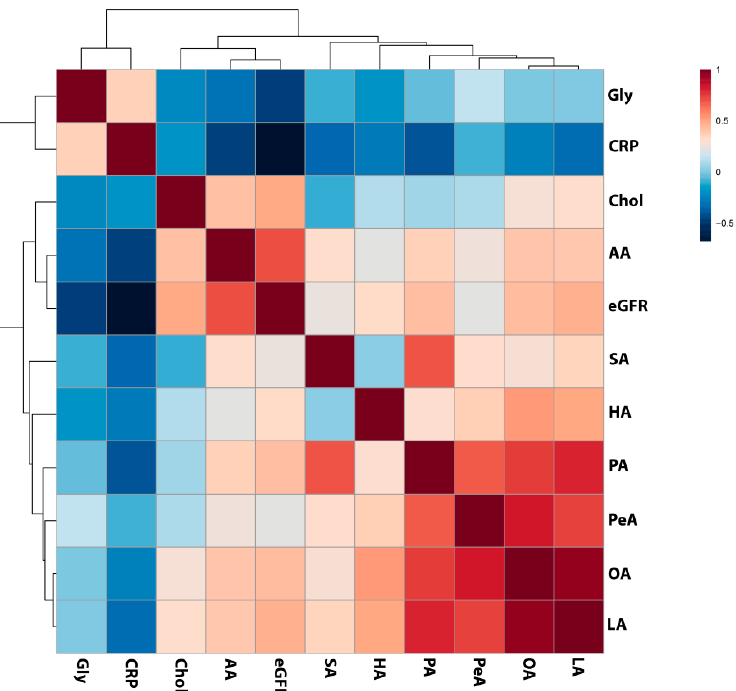
Figure 8. Results of the Spearman’s rank correlation test performed for compounds identified in GC/MS analyses as differentially accumulated between analyzed experimental groups and esti- mated glomerular filtration rate (eGFR) and C-reactive protein (CRP) level presented as a heat map with the corresponding hierarchical tree. Color saturation corresponds to the value of Spear- man’s correlation coefficient. Gly—glycerol, Chol—cholesterol, AA—arachidonic acid, SA- stearic